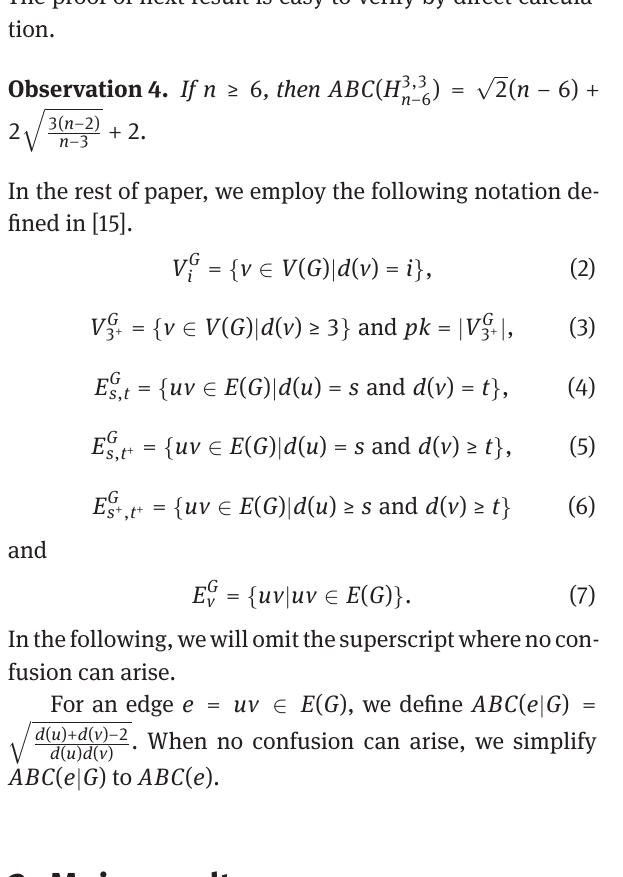
; (b) the graph H 3,3 s 3